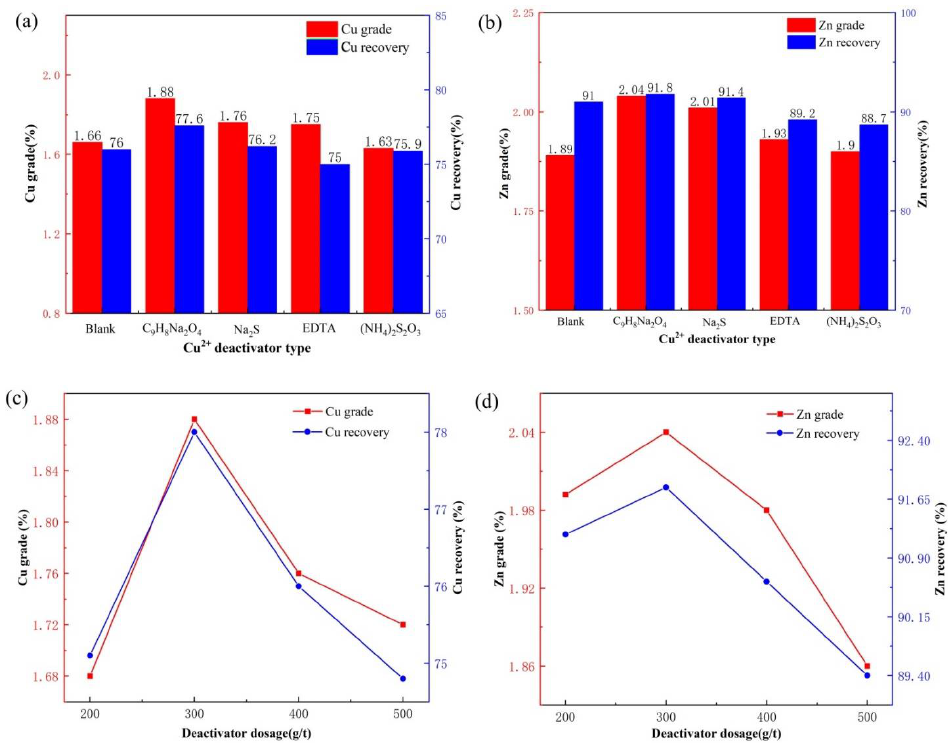
Figure 9. Effects of deactivator type ( a , b ) and dosage ( c , d ) on rough copper flotation.